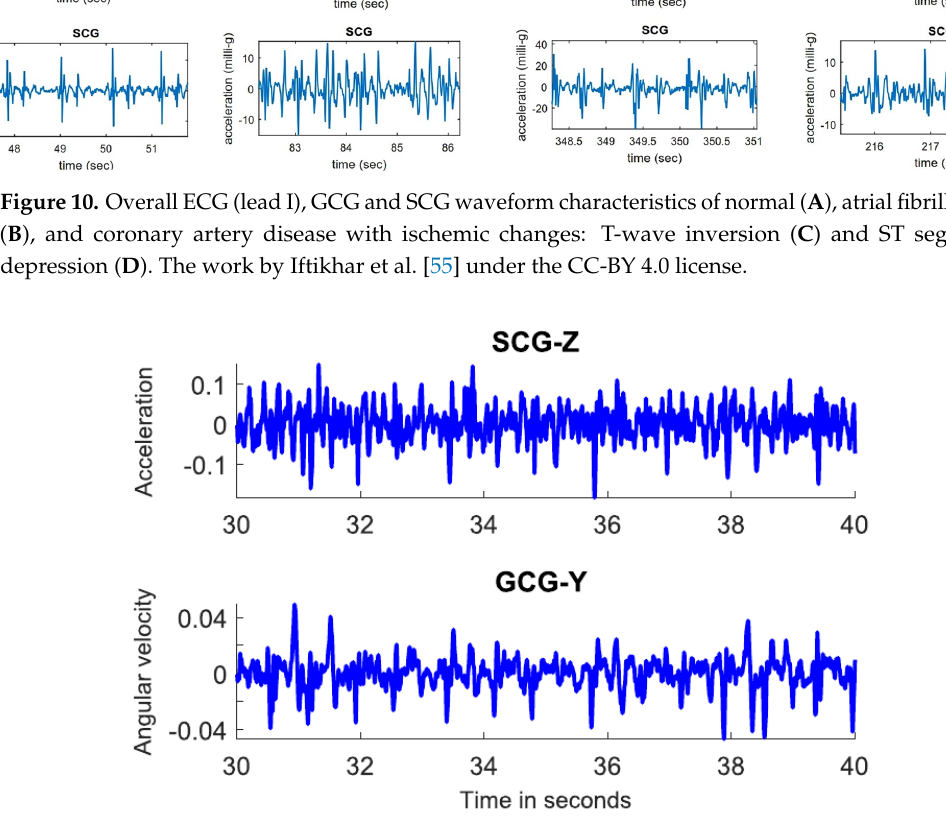
Figure 11. An example of AFib and acute decompensated heart failure in cardiac signals. An excerpt of the diagram published in Mehrang et al. work [77] shared under the license CC-BY